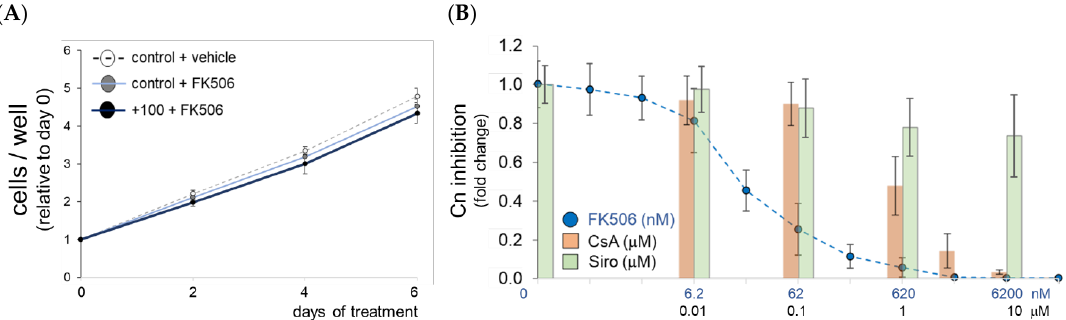
Figure 2. FK506 inhibits calcineurin activity, but not proliferation of ATDC5 cells. ( A ) Increasing the culture medium osmolarity by +100 mOsm/kg does not influence cell proliferation as compared to vehicle control (i.e., baseline plasma osmolarity), nor does FK506 (620 nM). ( B ) FK506 concentration more potently inhibits calcineurin (Cn) activity than cyclosporin (CsA). Dotted blue line: FK506 (nM); orange and green bars: CsA and Siro ( µ M), respectively. Data are means ± standard deviation of triplicate